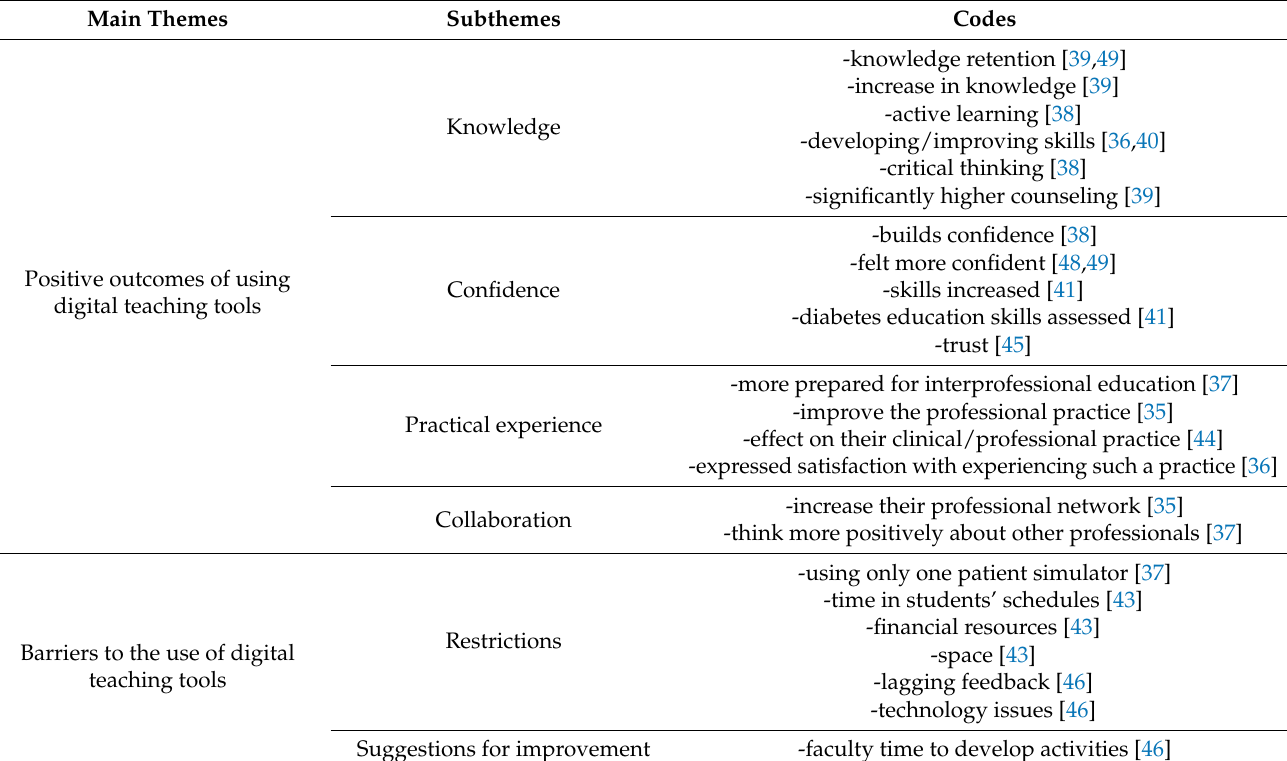
Table 4. Thematic